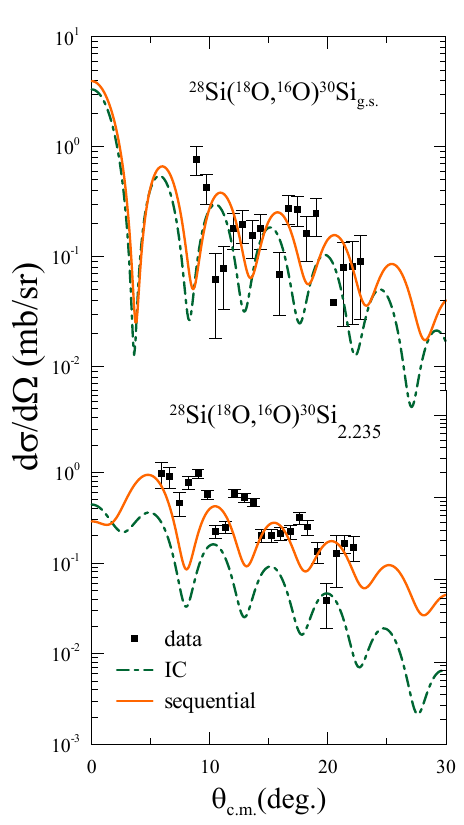
Fig. 2. Comparison of the experimental data and theoretical results corresponding to the 28 Si( 18 O, 16 O) 30 Si. IC means independent coordinates CRC calculations. Sequential stands for the sequential CCBA calculations.